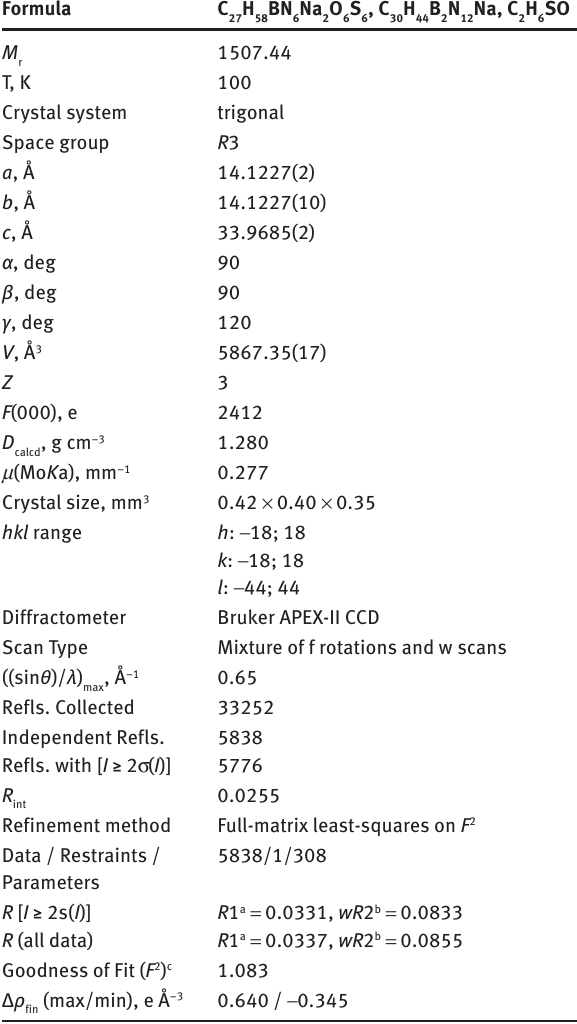
Table 1: Crystal structure data for 2 .